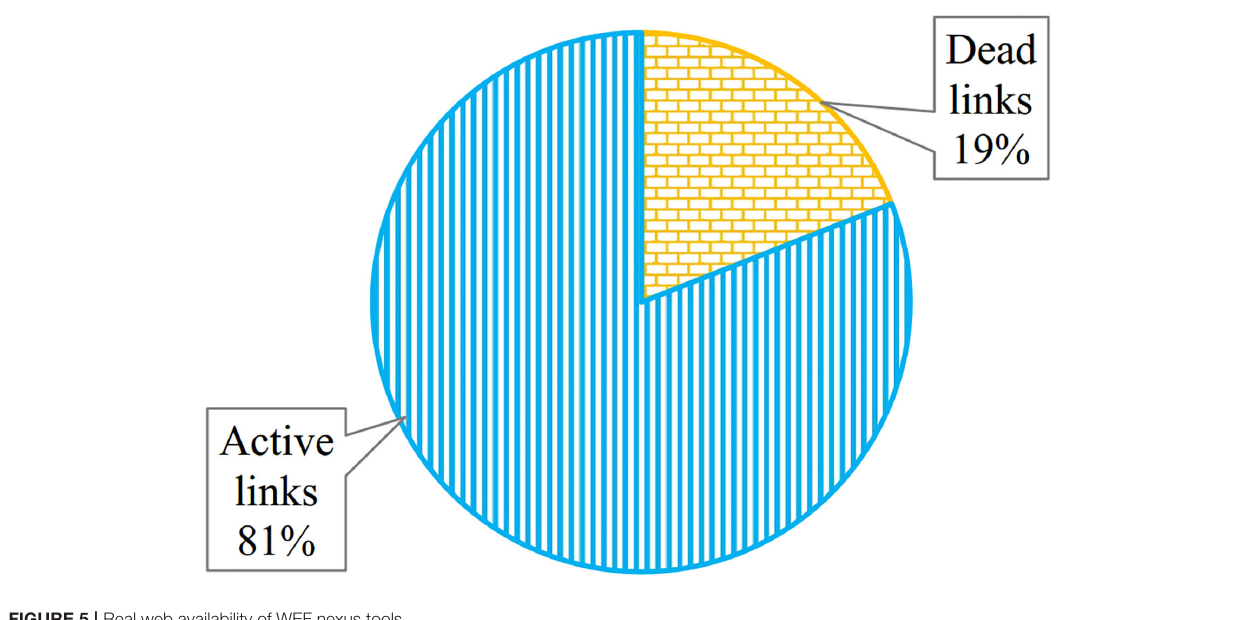
FIGURE 5 | Real web availability of WEF nexus tools.